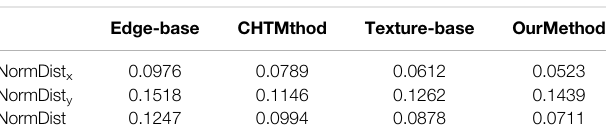
TABLE 5 | Comparison of average error.